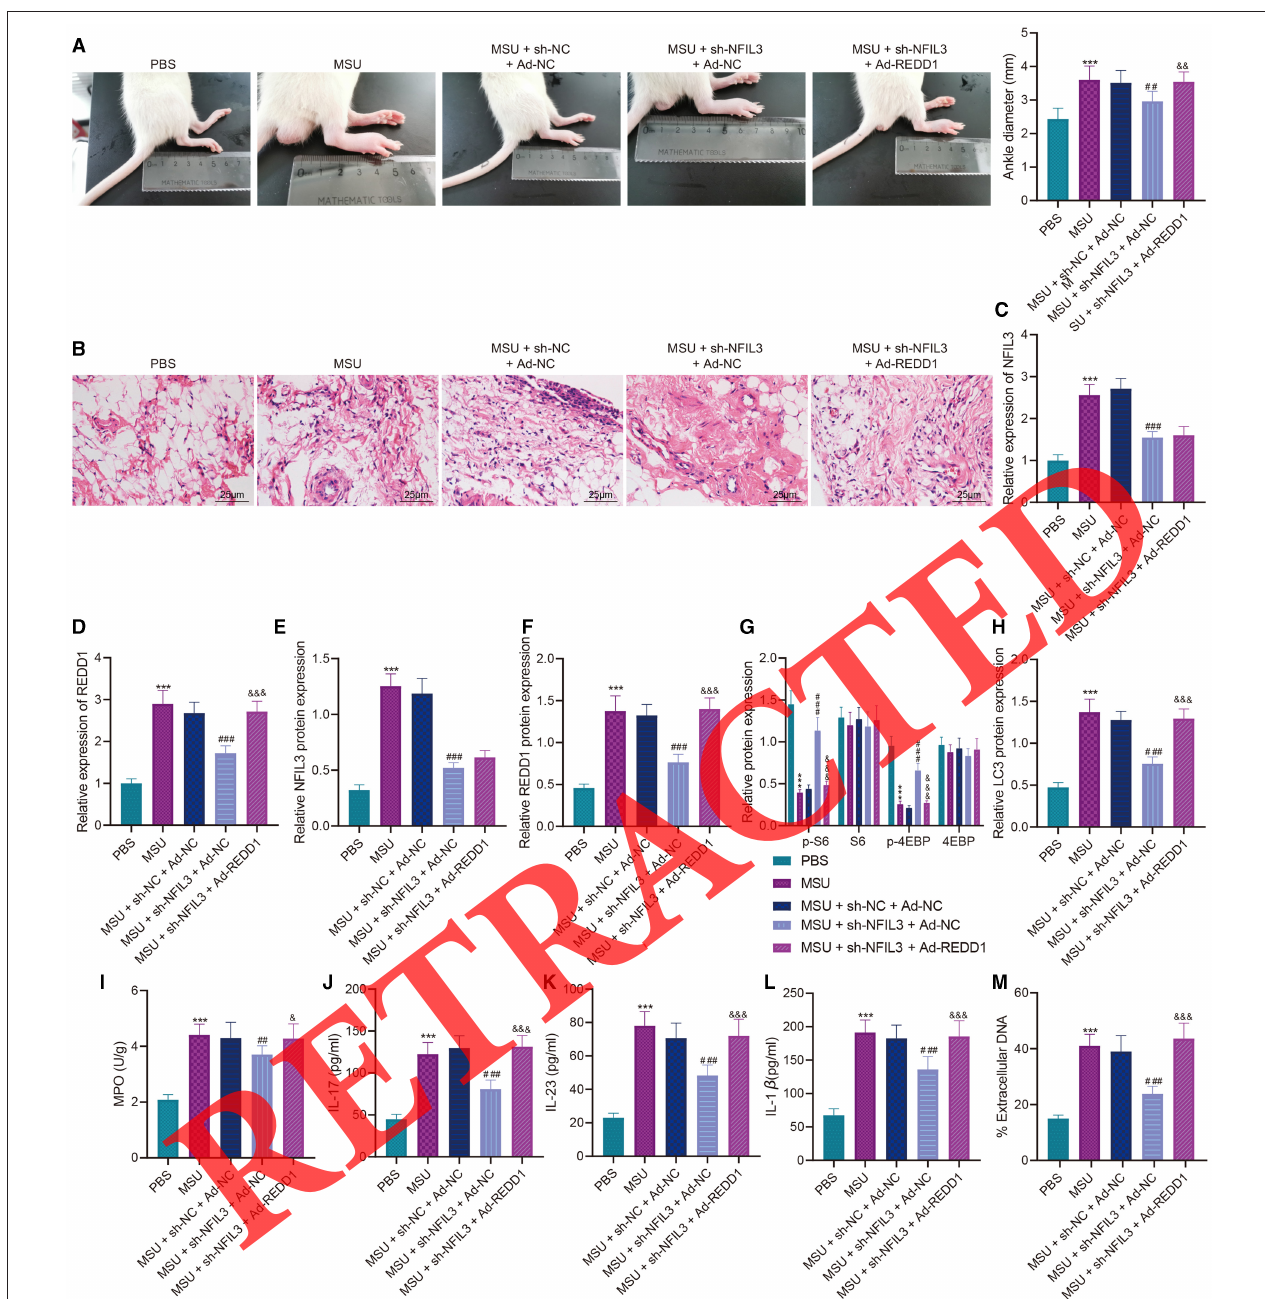
FIGURE 6 | NFIL3 silencing impairs neutrophil autophagy, reduces NET formation and inflammatory injury in mice with acute gouty arthritis via the REDD1/mTOR axis. PBS-treated mice served as the control and MSU mice were treated with sh-NFIL3 or combined with Ad-REDD1. (A) Representative microscopic views of ankle joint swelling of mice (the left), and the corresponding quantitative analysis (the right). (B) The representative images of pathological changes in the joint tissues of mice following HE staining, scale bar = 25 µ m. (C) mRNA expression of NFIL3 determined by RT-qPCR in the neutrophils of the joint tissue of mice. (D) mRNA expression of REDD1 determined by RT-qPCR in the neutrophils of the joint tissue of mice. (E) Western blot analysis of NFIL3 expression in the neutrophils of the joint tissues of mice. (F) Quantitative analysis of REDD1 protein expression. (G) Quantitative analysis of S6 and 4EBP phosphorylation levels. (H) Quantitative analysis of LC3 II protein expression. (I) MPO activity in the joint tissue of mice. (J) IL-17 levels measured by ELISA in the serum of mice. (K) IL-23 levels measured by ELISA in the serum of mice. (L) IL-1 β levels measured by ELISA in the serum of mice. (M) Quantitative analysis of NET formation in the joint tissue of mice. *** p < 0.001, compared to PBS-treated mice. ## p < 0.01, compared to MSU mice treated with sh-NC + Ad-NC. ### p < 0.001, compared to MSU mice treated with sh-NC + Ad-NC. &, && or &&& p < 0.05, compared to MSU mice treated with sh-NFIL3 + Ad-NC. Data are shown as mean ± standard deviation of three technical replicates. Data among multiple groups were assessed by one-way ANOVA. n = 10 for mice in each